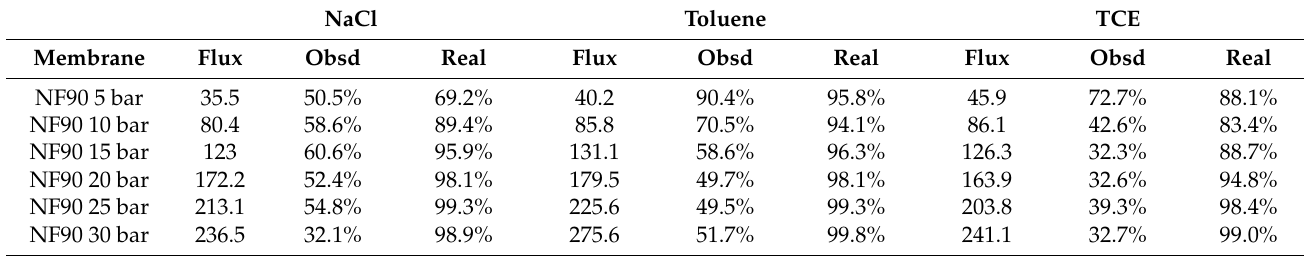
Table 12. Laboratory separation assessment trials using nanofiltration and reverse osmosis membranes. a. Dow NF90 membrane flux (LMH) and observed and real rejection data for NaCl, toluene and trichloroethylene from conductivity and TOC measurements. Toluene